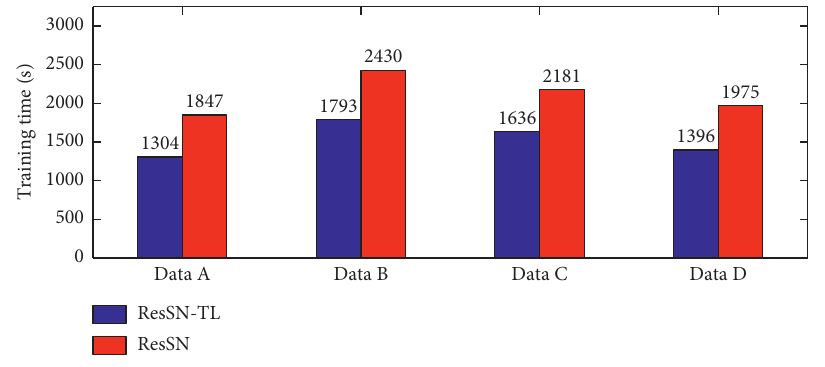
Figure 14: Training time of ResSN and ResSN-TL. Table 8: Gearbox dataset RMSE for different methods on RUL prediction.